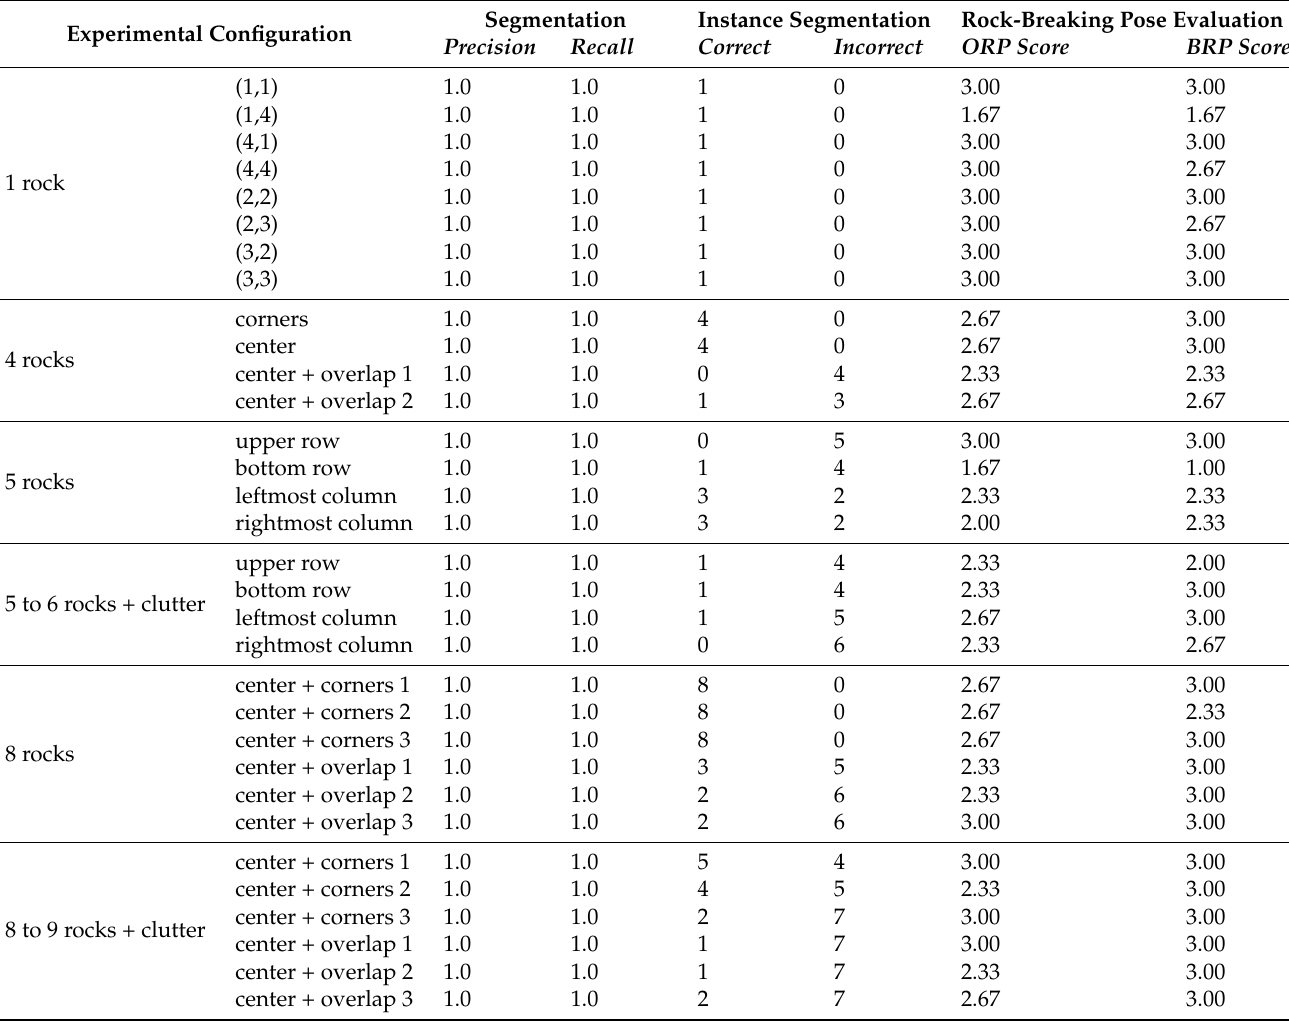
Table 2. Performance metrics for the experiments conducted in the real world. ORP score: Overall Rock-breaking Pose score. BRP score: Best Rock-breaking Pose score.